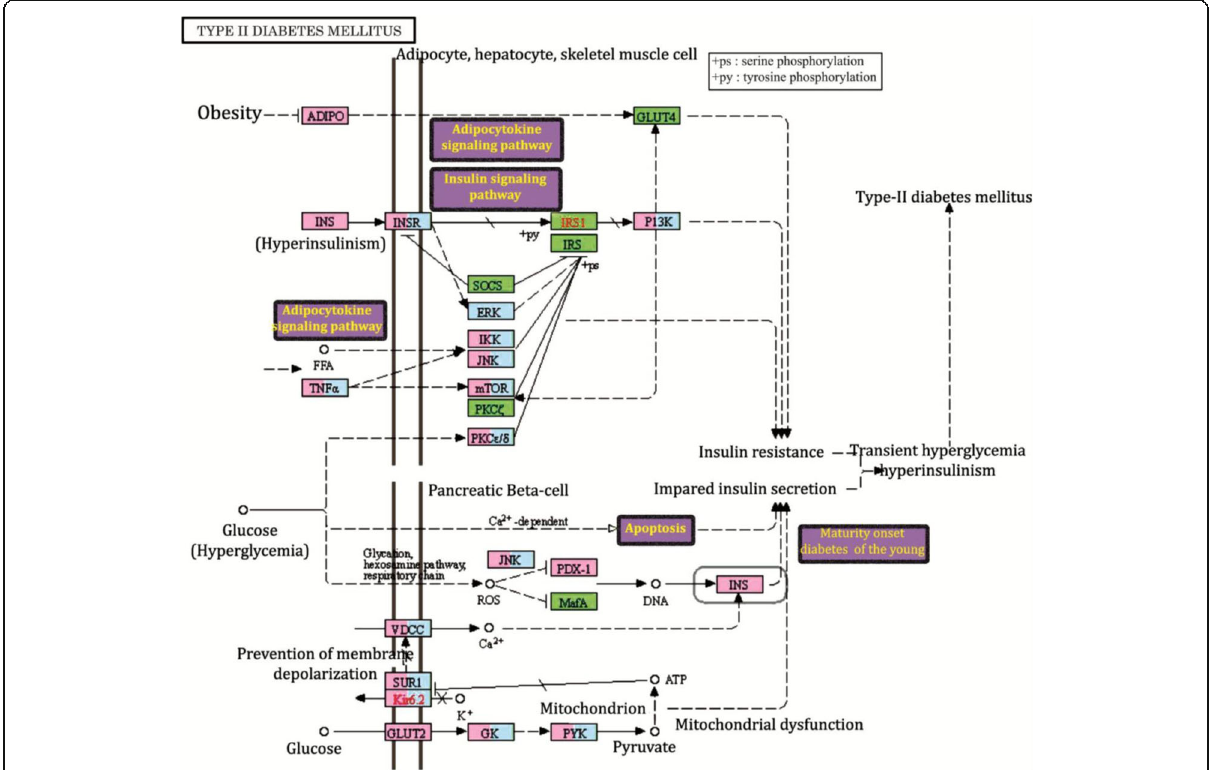
Fig. 3 Human type-II diabetes mellitus pathways that serve the drug target site for controlling diabetic complications (pink indicates diseased gene and blue indicates drug target